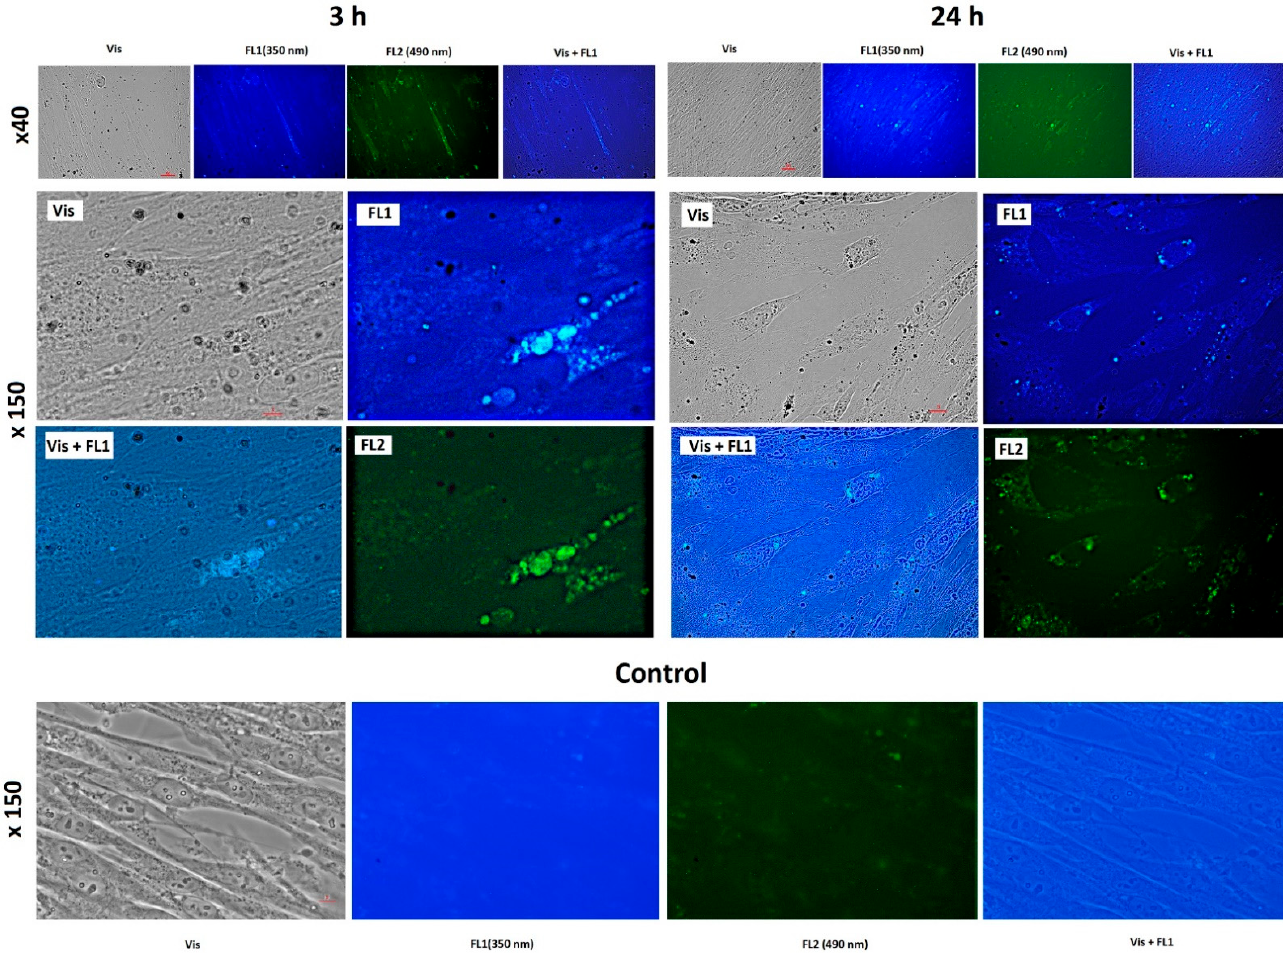
Figure 4. Fluorescence of C 60 (concentration 1.5 µM) in the cells after 3 and 24 h of incubation: Vis, transmitted light, fluorescence was registered with a 450–525 nm filter, excitation wavelength 350 nm (FL1) and 490 (FL2); magnification is shown at the left. Scale is marked with red bars. The bottom series of photographs are images of cells incubated without the fullerene (a control experiment).